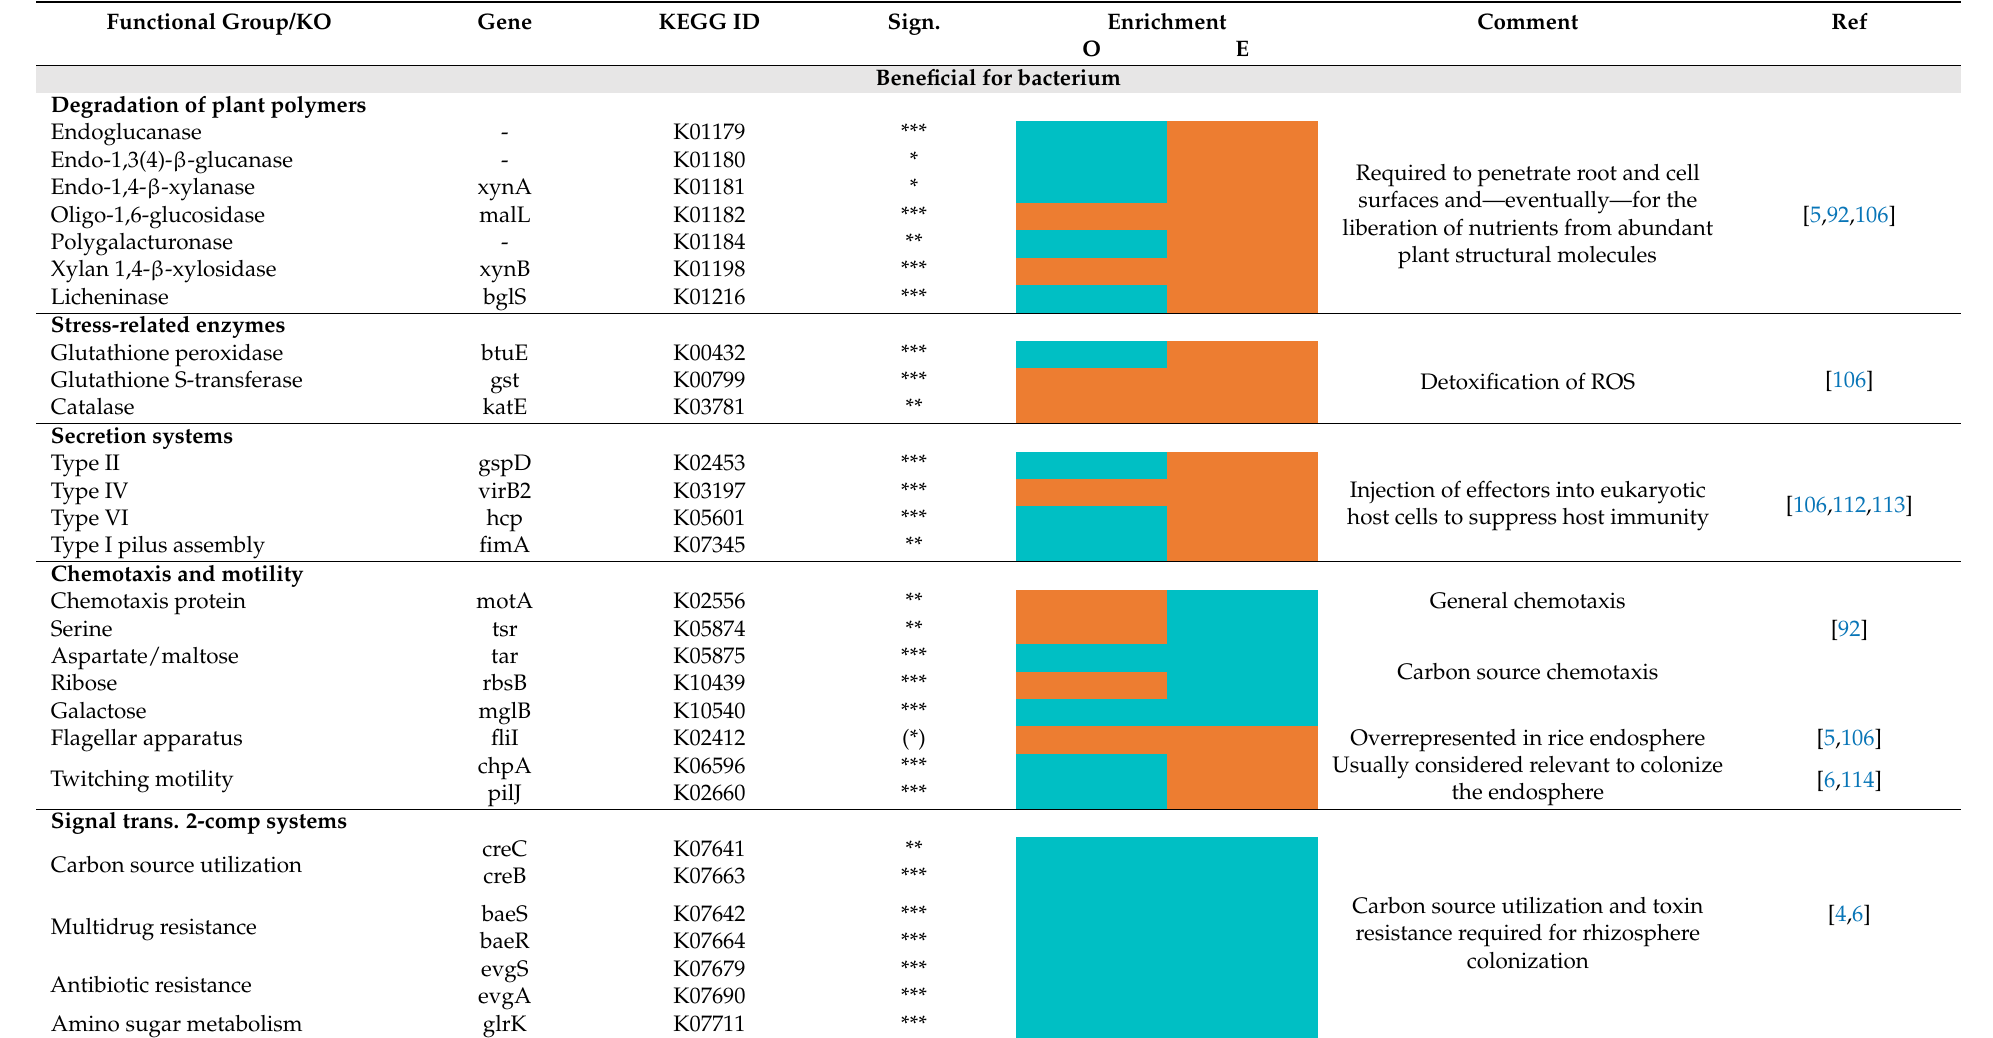
Table 3. Predicted genes with beneficial effects for the bacterium, the plant, or both partners: observed and expected enrichment in the rhizosphere versus endosphere 1 . Functional Group/KO Gene KEGG ID